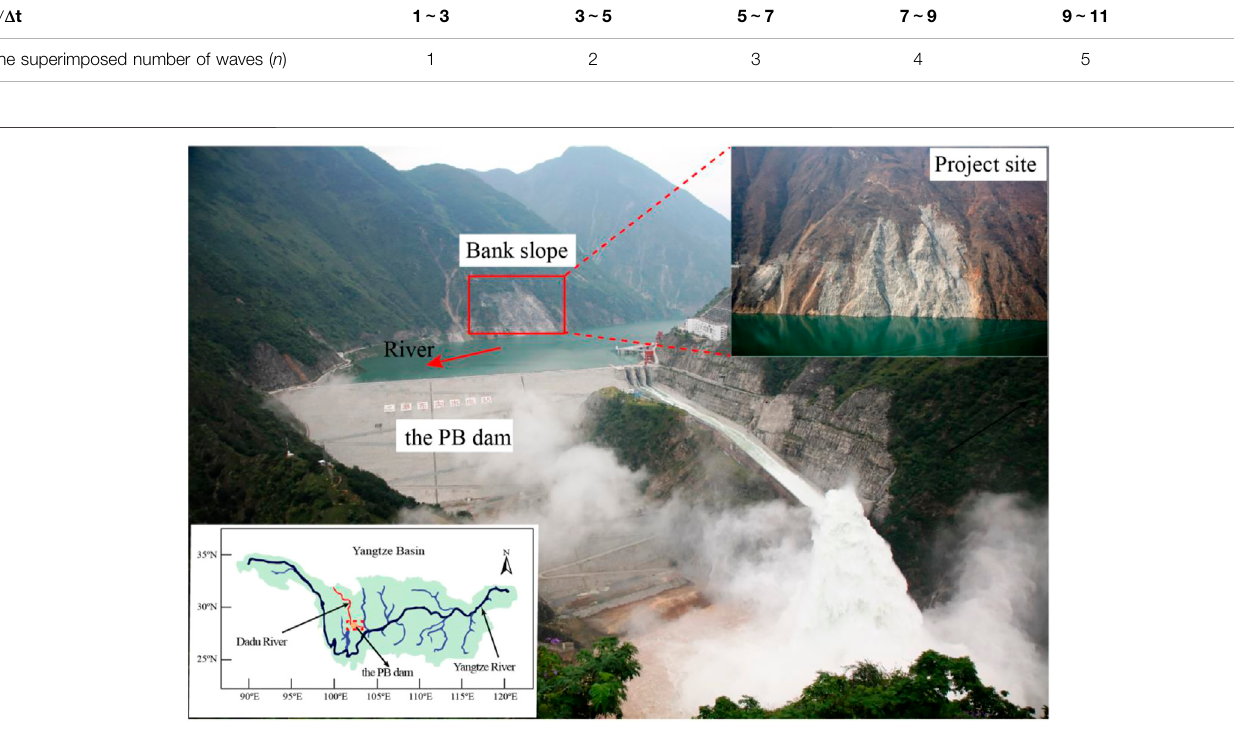
FIGURE 3 | The map of the PB dam and the reservoir bank